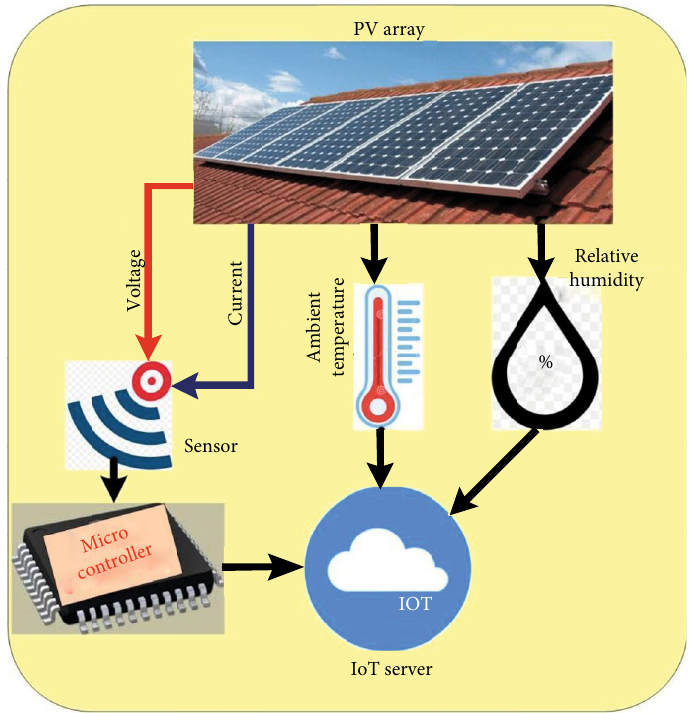
Figure 1: Data from PV panel to an IoT